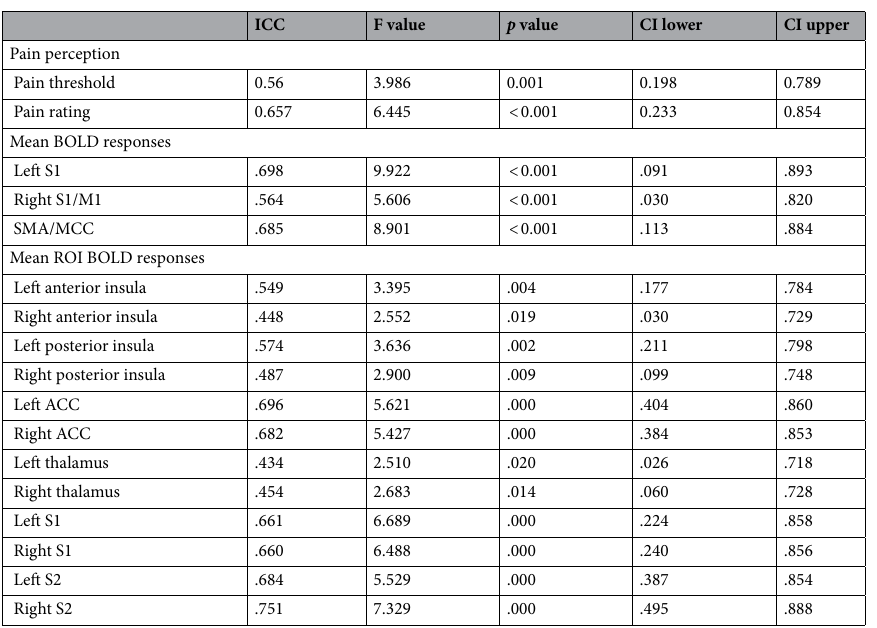
Table 2. Intraclass correlation coefficients of pain perception and laser-evoked brain responses between the two sessions. The intraclass correlation coefficients (ICCs) were calculated using the single-rating, absolute- agreement, 2-way mixed model. 95% confidence interval (CI) is the interval between CI lower and CI upper. ROI, region of interest; S1, primary somatosensory cortex; S2, secondary somatosensory cortex; M1, primary motor cortex; SMA, supplementary motor area; MCC, middle cingulate cortex; ACC, anterior cingulate cortex. Bonferroni correction, p < 0.025 for pain perception analyses and p < 0.05/15 for brain response